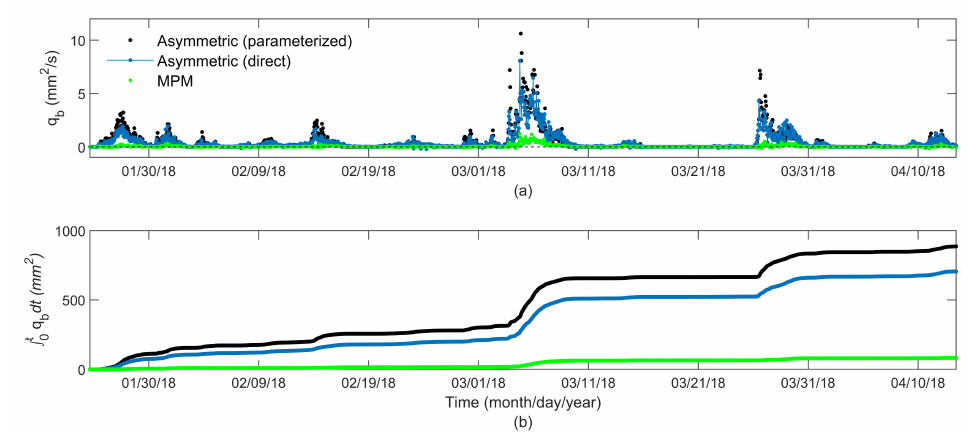
(cid:82) t q b dt ) wave-driven bedload 0